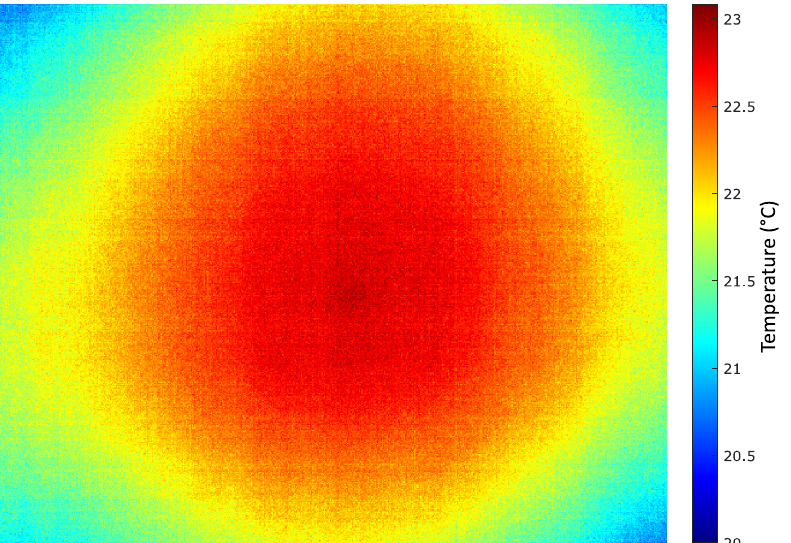
Figure 14. Vignetting effect of the thermal camera. The color bar indicates the temperature in degree Celsius.